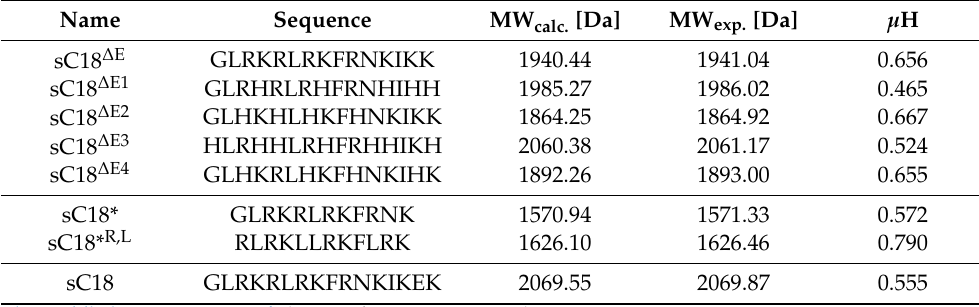
Table 1. Names, sequences, molecular weights and hydrophobic moments ( µ H a ) of synthesized peptides. Peptides were generated as C -terminal